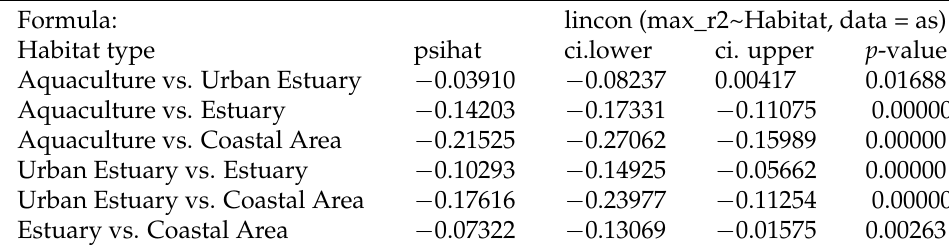
Table A3. Results of post hoc lincon test from the package WRS2 [61].